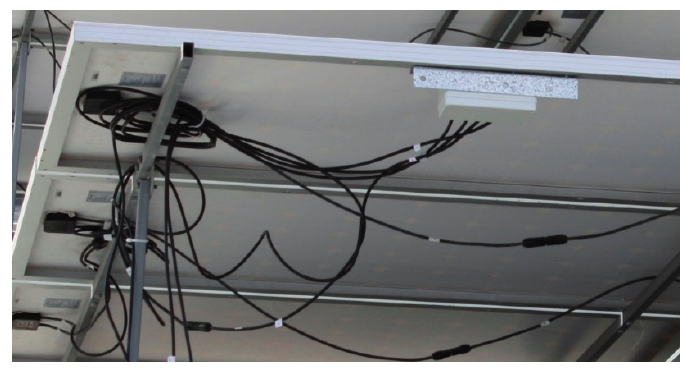
Figure 8. Example of application: sensor nodes on PV